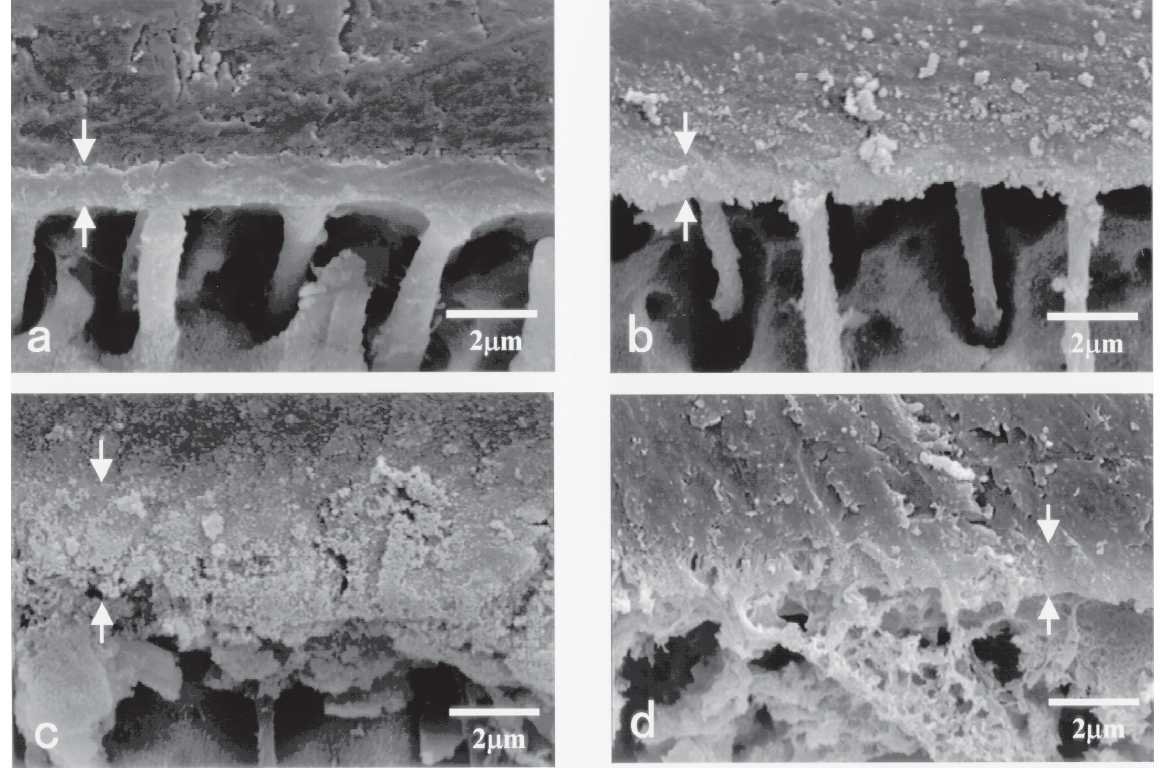
FIGURE 8 -SEM micrographs of the resin-dentin interfaces in coronal dentin (a),root dentin(b),caries-affected dentin(c) and caries-infected dentin(d). In the coronal dentin, many resin tags and a firm hybrid layer are observed (Figure8a). In the root dentin, a hybrid layer shows the porous structure and the tags structures are thin (Figure8b). In caries-affected and caries- infected dentin, hybrid-layer-like structure shows the porous morphology and tag-like structure is irregular